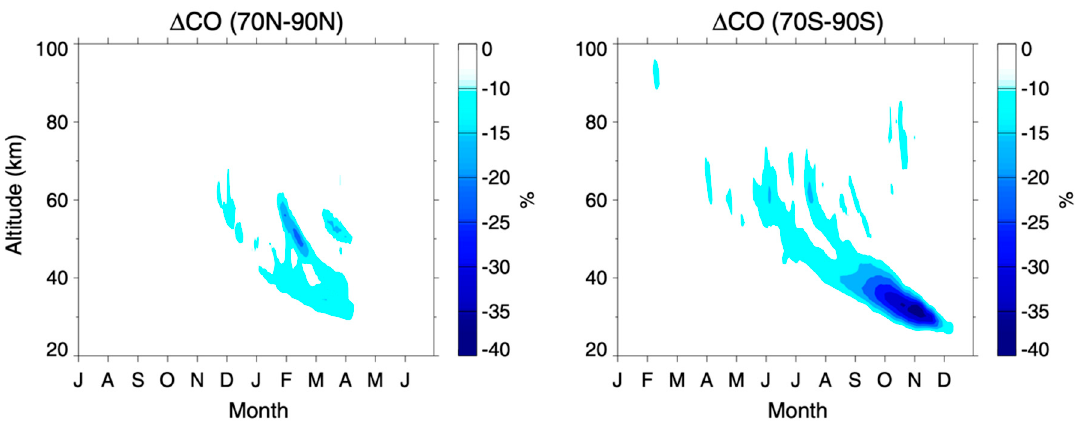
Figure 8. Seasonal variations of the relative changes ((MEE-Control)/Control) are presented for the zonal mean volume mixing ratios of CO averaged in the latitude range of 70°–90° N/S from 2005 to 2013. The 7-day moving average was applied.